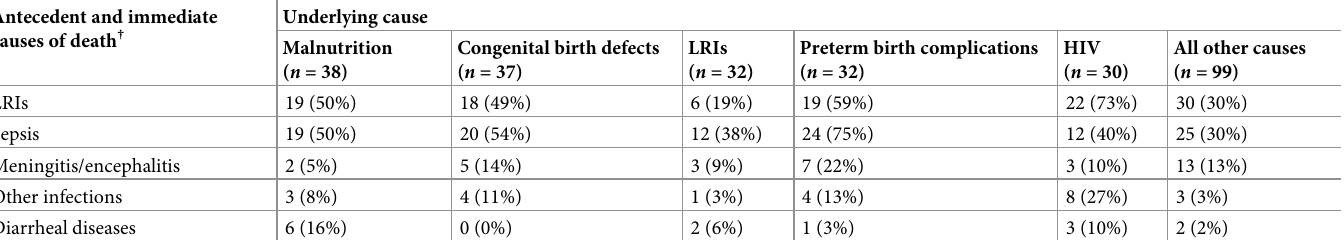
Table 8. Most common additional conditions (antecedent and immediate CoD) in the causal chain for the 5 leading underlying causes of infant deaths in CHAMPS.